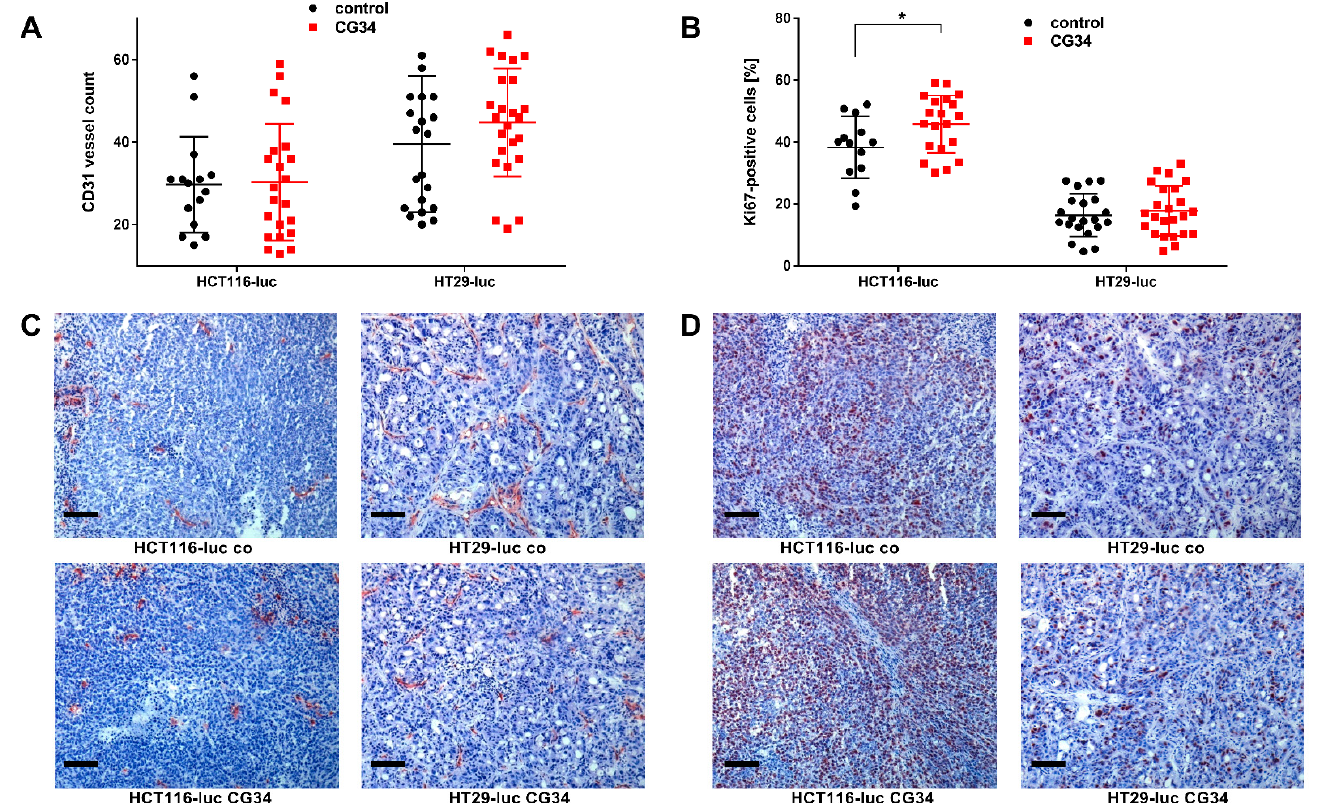
Figure 6. Immunohistological analysis and quantitation of vessel density (CD31 staining; ( A , C )) and proliferative activity (Ki67 staining; ( B , D )) in sections of xenograft tumors after the treatment study (Figure 5). Quantitative data ( A , B ) represent mean ± SD of n = 15–24 analyzed microscopic imaging fields. Statistical testing was performed using an unpaired t -test; * p < 0.05. Scale bars: 50 µ